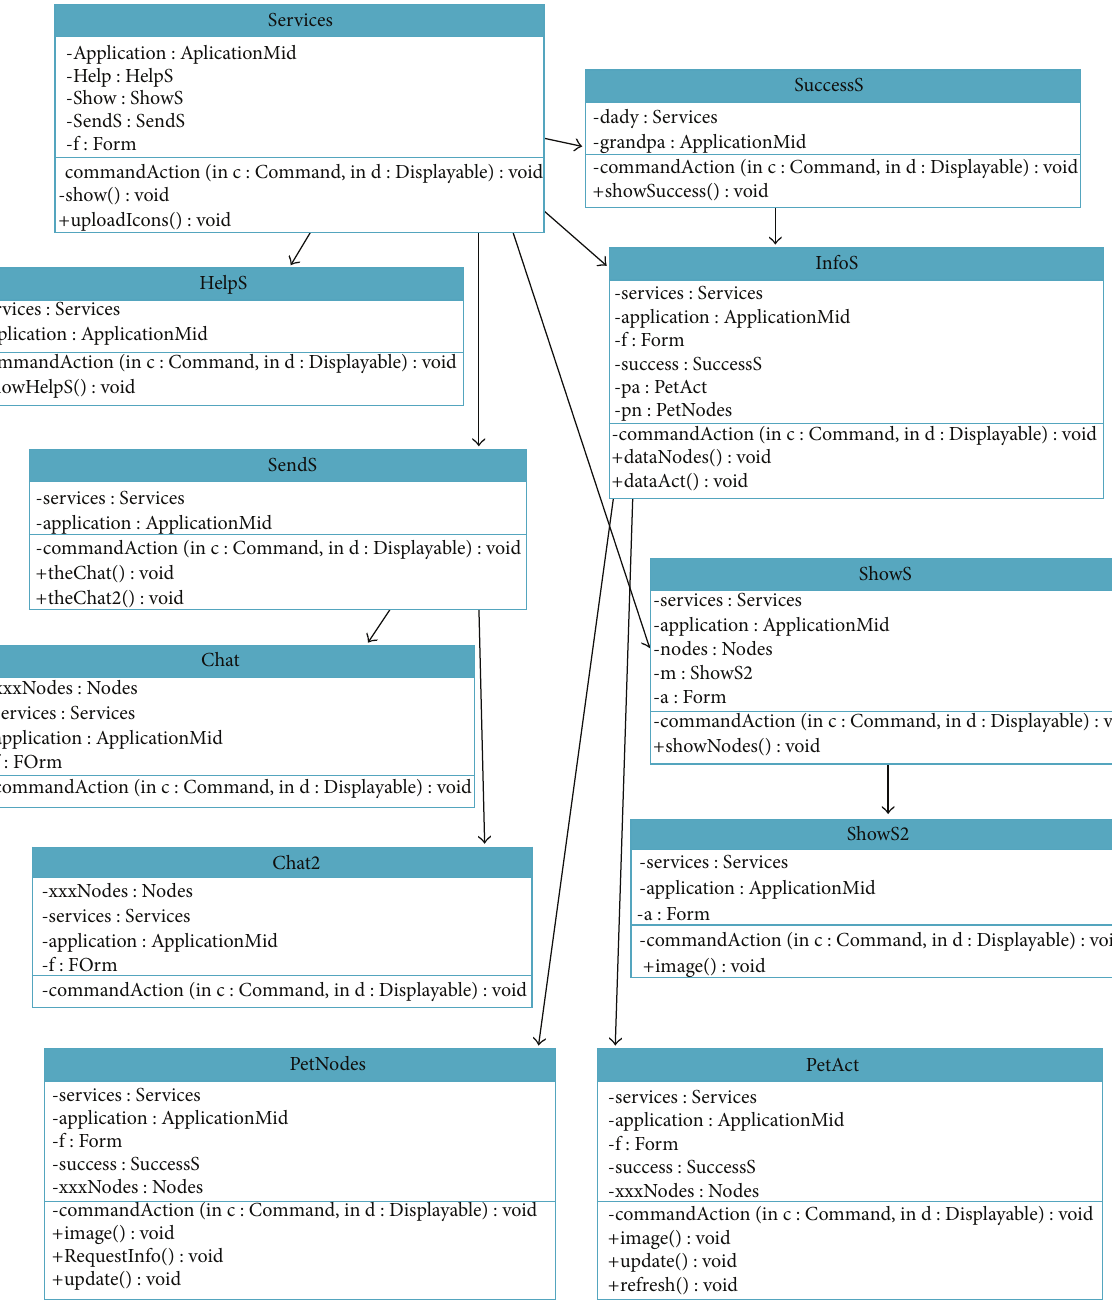
Figure 18: Request diagram